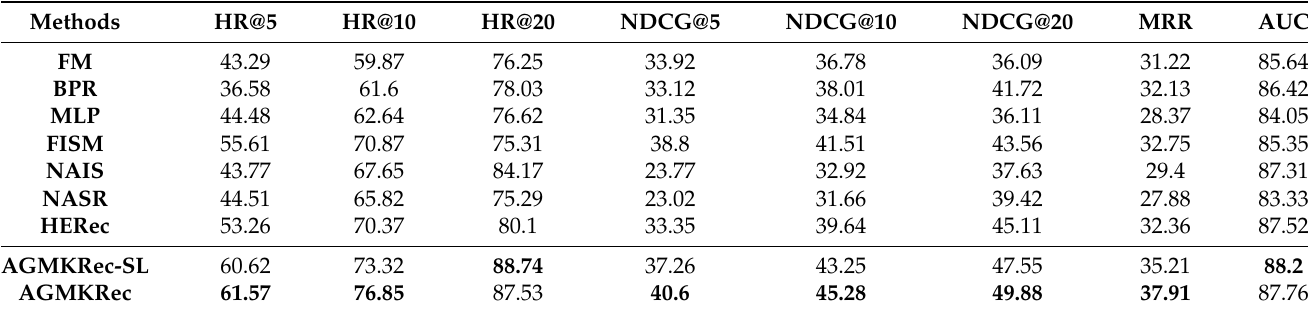
Table 3. Recommendation performance of all methods (%).